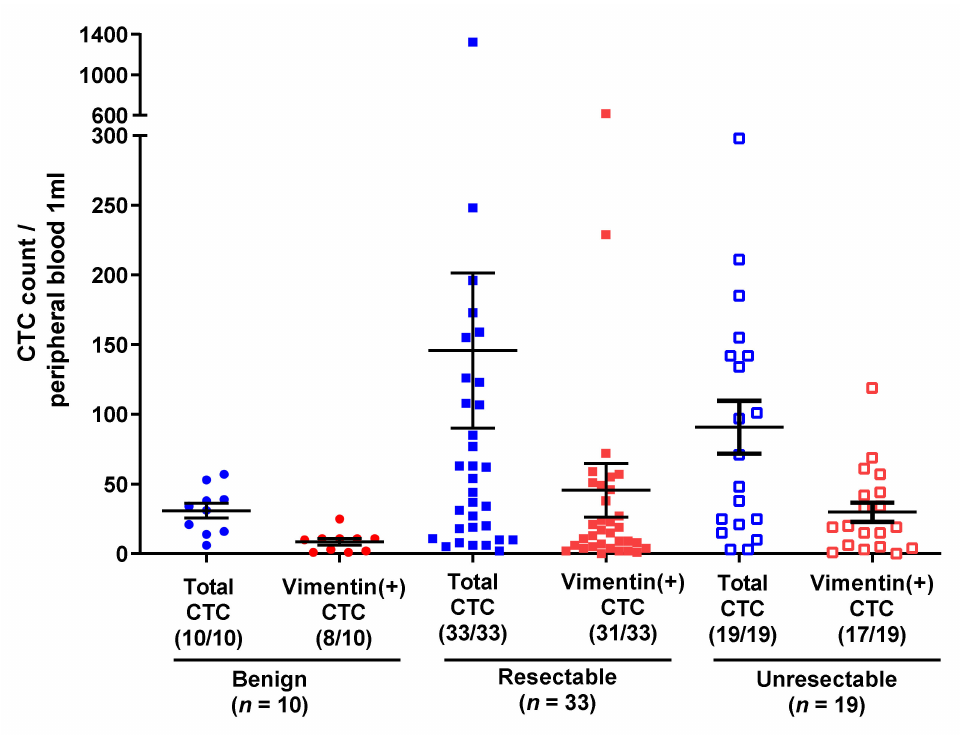
Figure 3. CTC counts and V-CTC counts in patients with biliary disease.